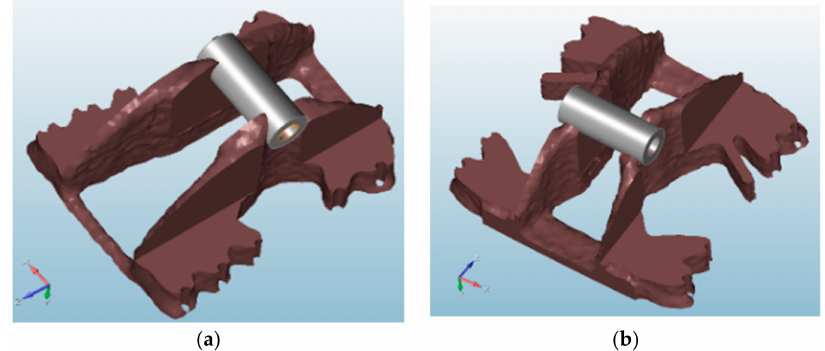
Figure 10. Supports’ topology optimization results: ( a ) upper support; ( b ) lower support.